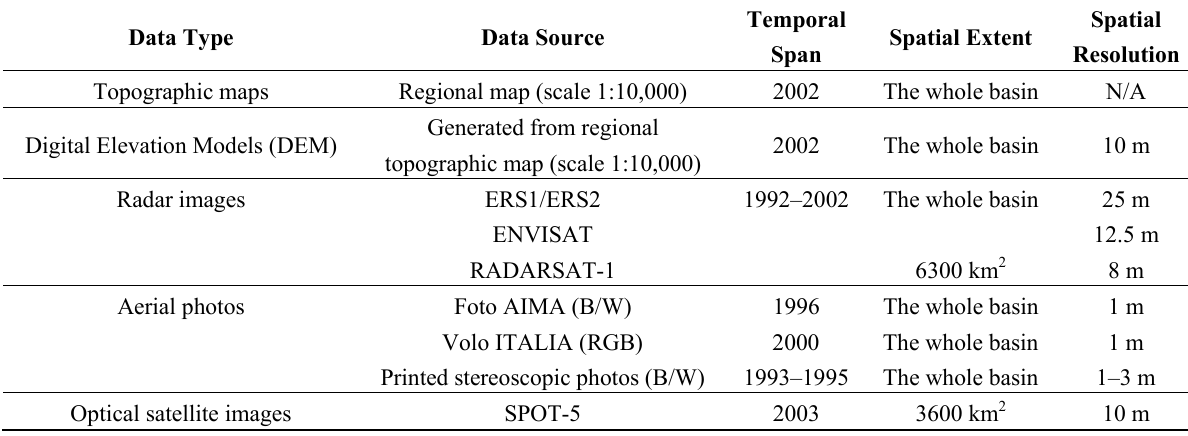
Table 1. Datasets used for the landslide inventory mapping within the Arno River basin.